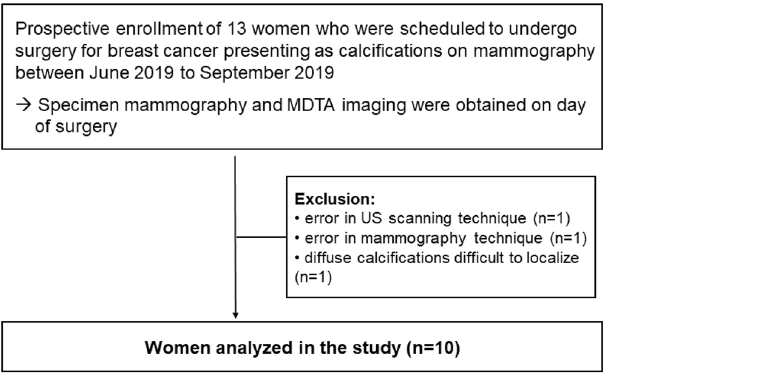
Figure 1. Flowchart of study